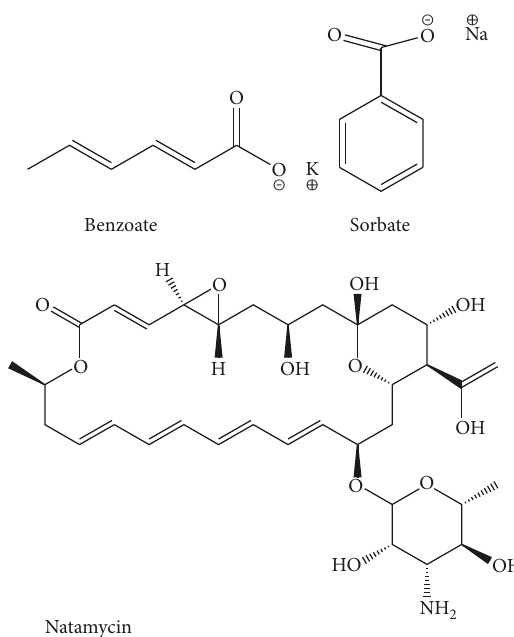
Figure 1: Chemical structures of sodium benzoate, potassium sor- bate, and